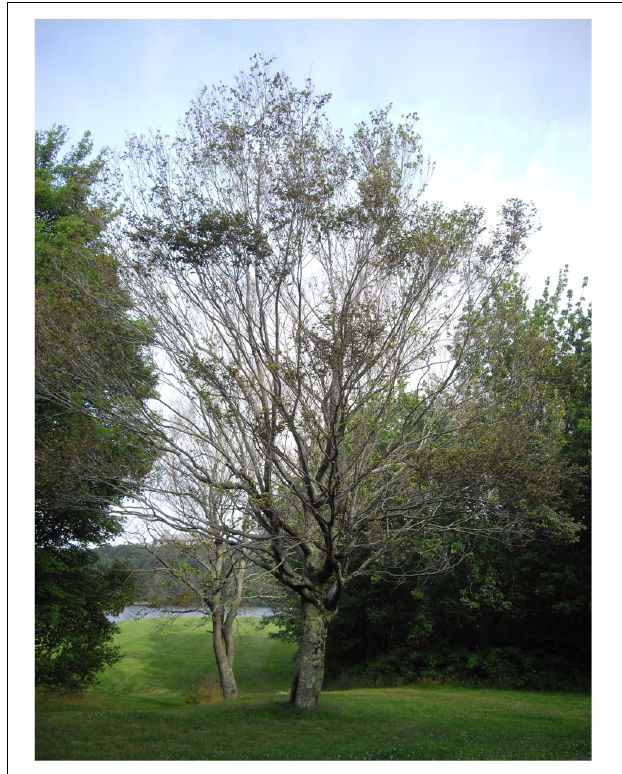
FIGURE 1 | American beech with thin crown as a result of beech weevil defoliation, Dartmouth, Nova Scotia, July 2012 (photo credit: J.